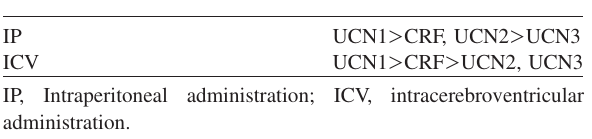
Table 2 Ranking order of potency for feeding inhibition after peripheral or central